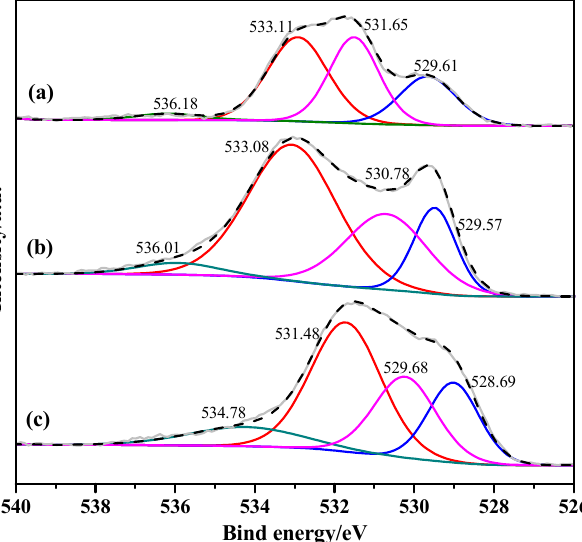
Figure 11. XPS scans on O 1s for ( a ) TiO 2 , ( b ) fresh MnTi catalyst, and ( c ) reduced MnTi catalyst . Table 1. Composition of the surface O species for fresh and spent MnTi catalyst and TiO 2.